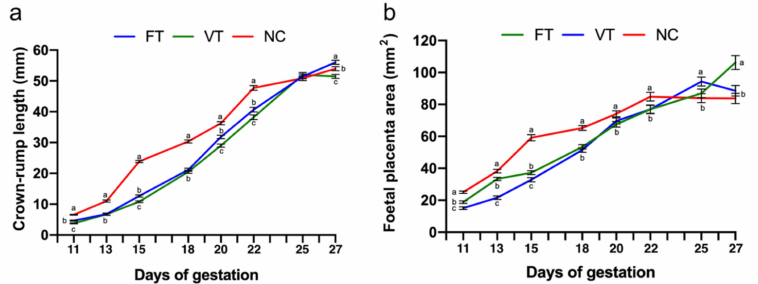
Figure 1. Identification of foetal growth and foetal placental area di ff erences in foetuses born after the embryo manipulation during the fresh transfer procedure (FT) or vitrified-transfer procedure (VT) compared to nonmanipulated (NC) animals. Measures were determined by ultrasonography. ( a ) Crown-rump length of the foetus. ( b ) Foetal placental area. n = 40 foetuses in each group. Day of gestation with di ff erent superscript letters are significantly di ff erent ( p ≤ 0.05). Data represent the least square means and standard errors of the